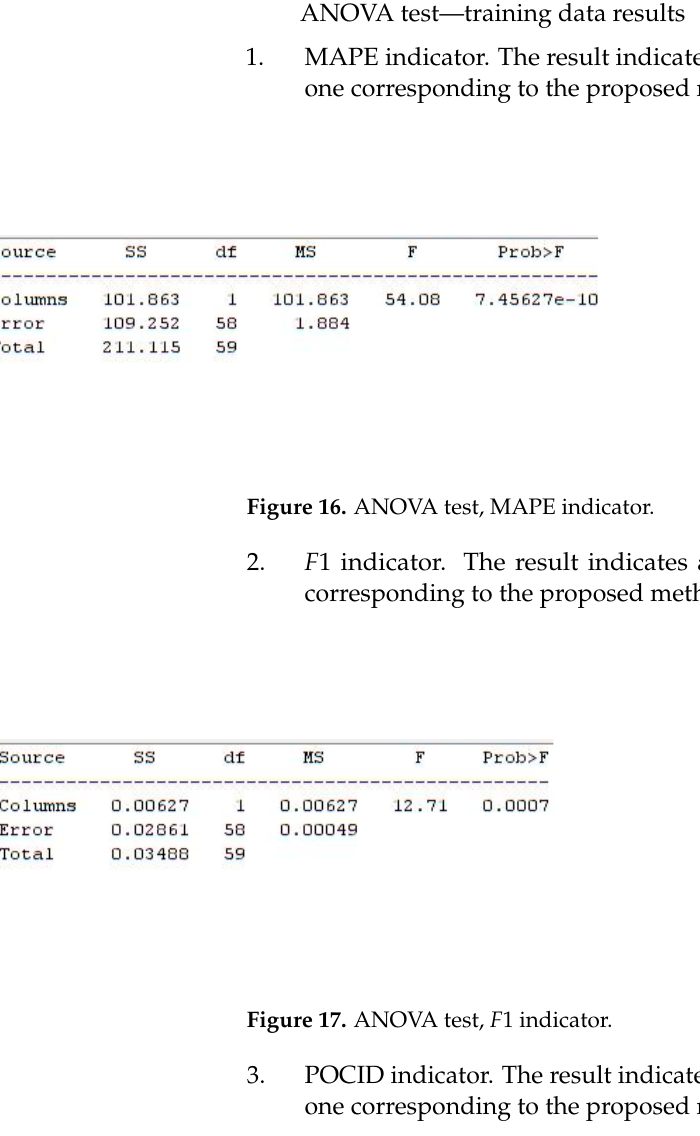
Figure 18. ANOVA test, POCID indicator. ANOVA test—test data results 1. MAPE indicator. The result indicates a similarity between the MAPE values.